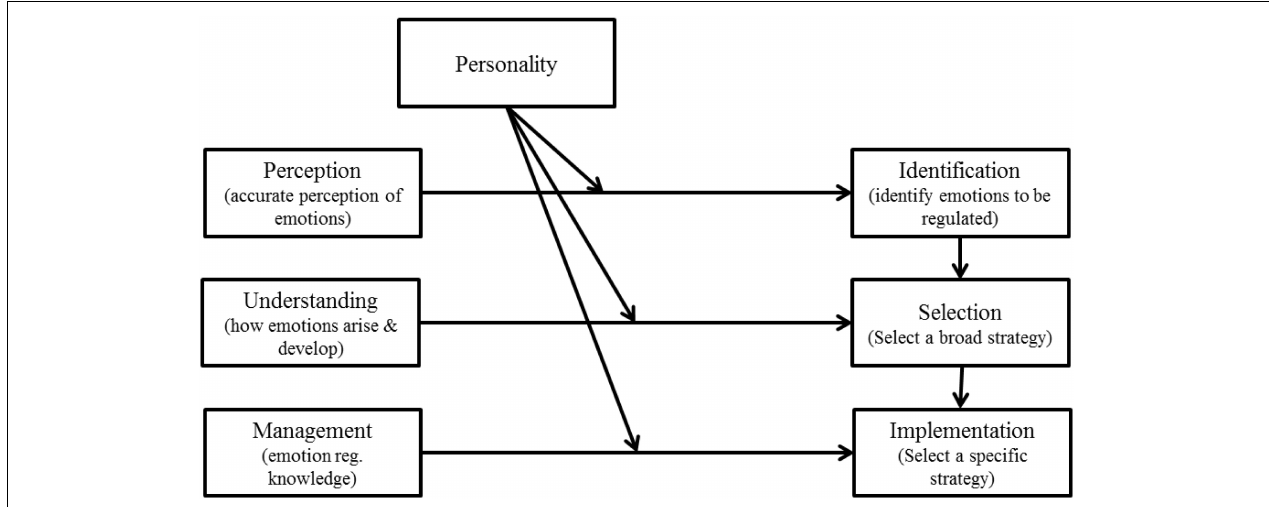
FIGURE 3 | Possible interactions between the sub-factors of ability EI and personality traits in explaining the identification, selection, and implementation of emotion regulation strategies.